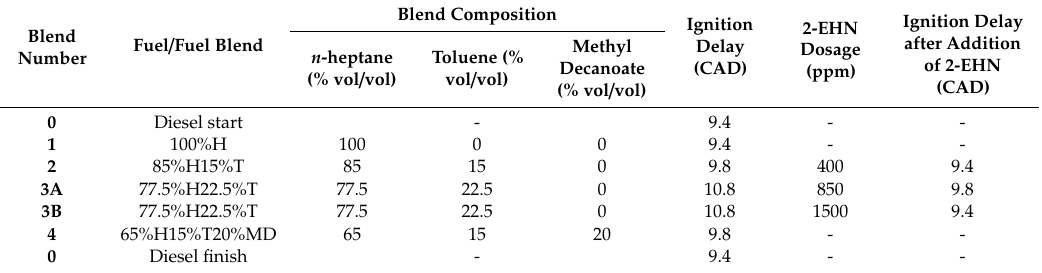
Table 3. Fuel blend composition and experimental matrix for the test fuels run in a compression ignition